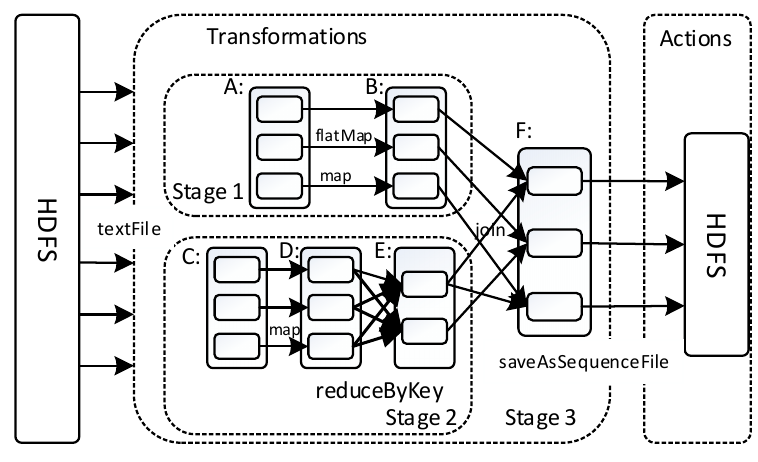
Figure 5. Spark operating mechanism.